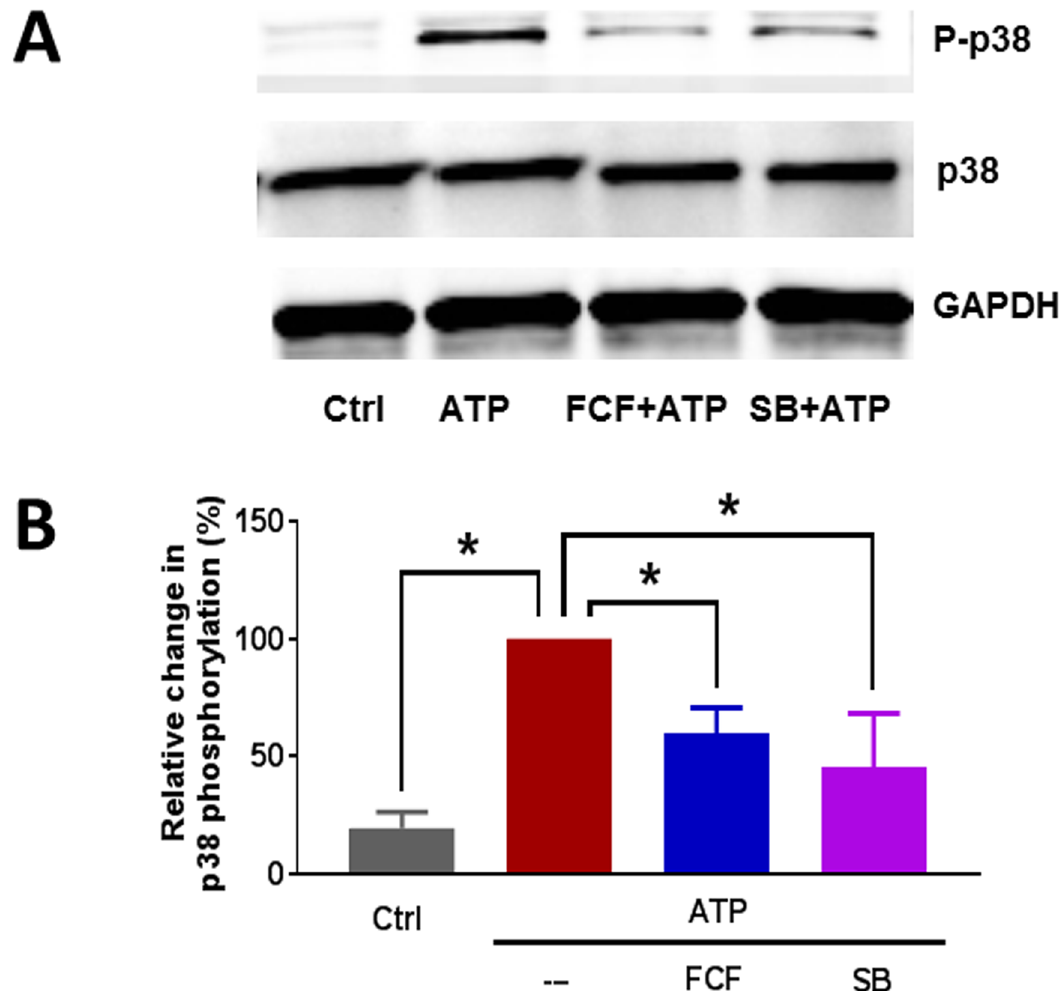
Fig 4. eATP induced phosphorylation of p38 MAPK in HSV endothelial cells. HSVEC were untreated(Ctrl), or treated with ATP (2 mM) for 30 minutes. Some cells were pre-treatedwith FCF (100 μ M), or SB203580(SB, 20 μ M) for 1 hour. Phospho-p38 MAPK and total p38 MAPK proteinswere quantitated with immunoblotting (adjustedto the loading control GAPDH). ( A ) Representative western blots of phospho-p38MAPK and p38 MAPK. (B ) Cumulative data showing the relative percent phosphorylation of p38 MAPK. Phosphorylationwith eATP alone was set as 100%, n = 4 passages, * p < 0.05, (One way